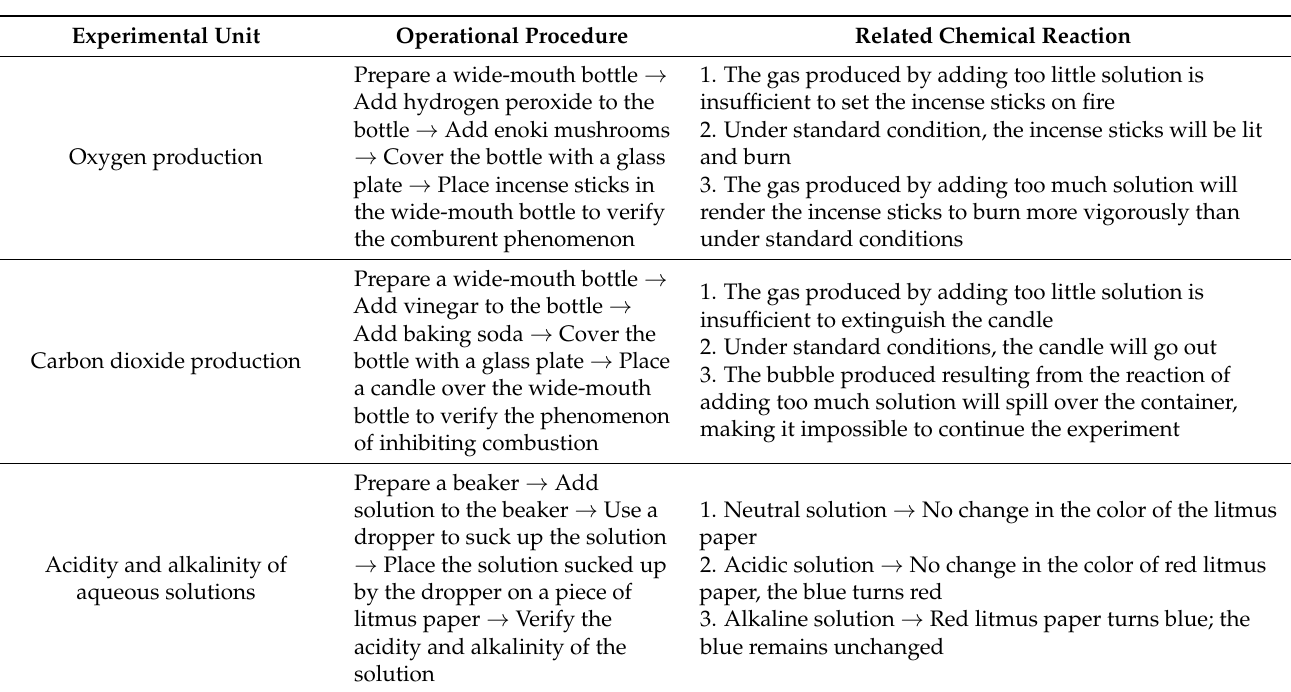
Table 6. Operational concepts of each experimental